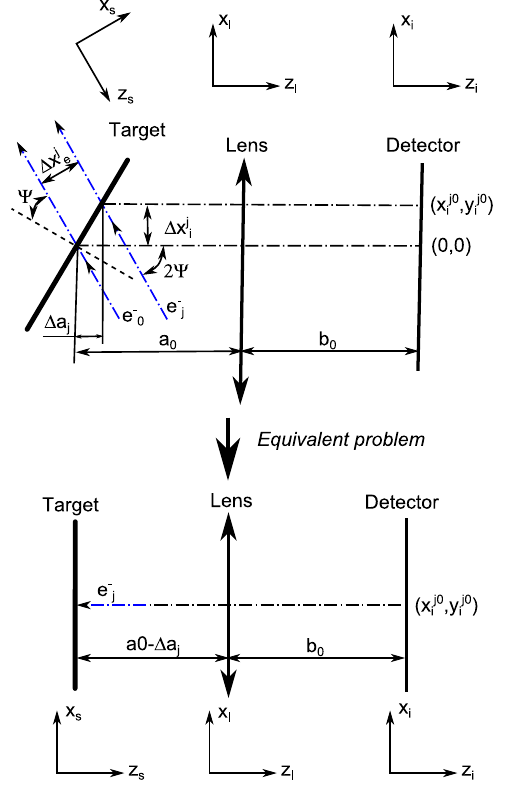
FIG. 3. Calculation scheme for the inclined target geometry together with geometrical definitions.